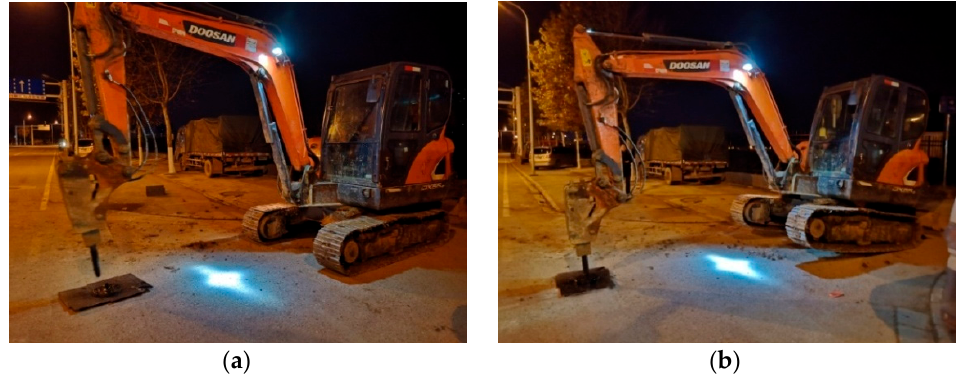
Figure 5. Two perturbation postures of the excavator: ( a ) fullyand ( b ) partially touching the ground .